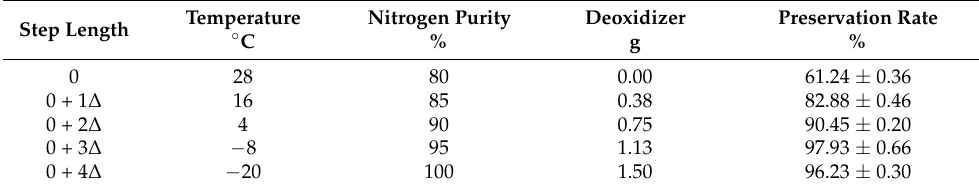
Table 2. Result of path of steepest ascent.